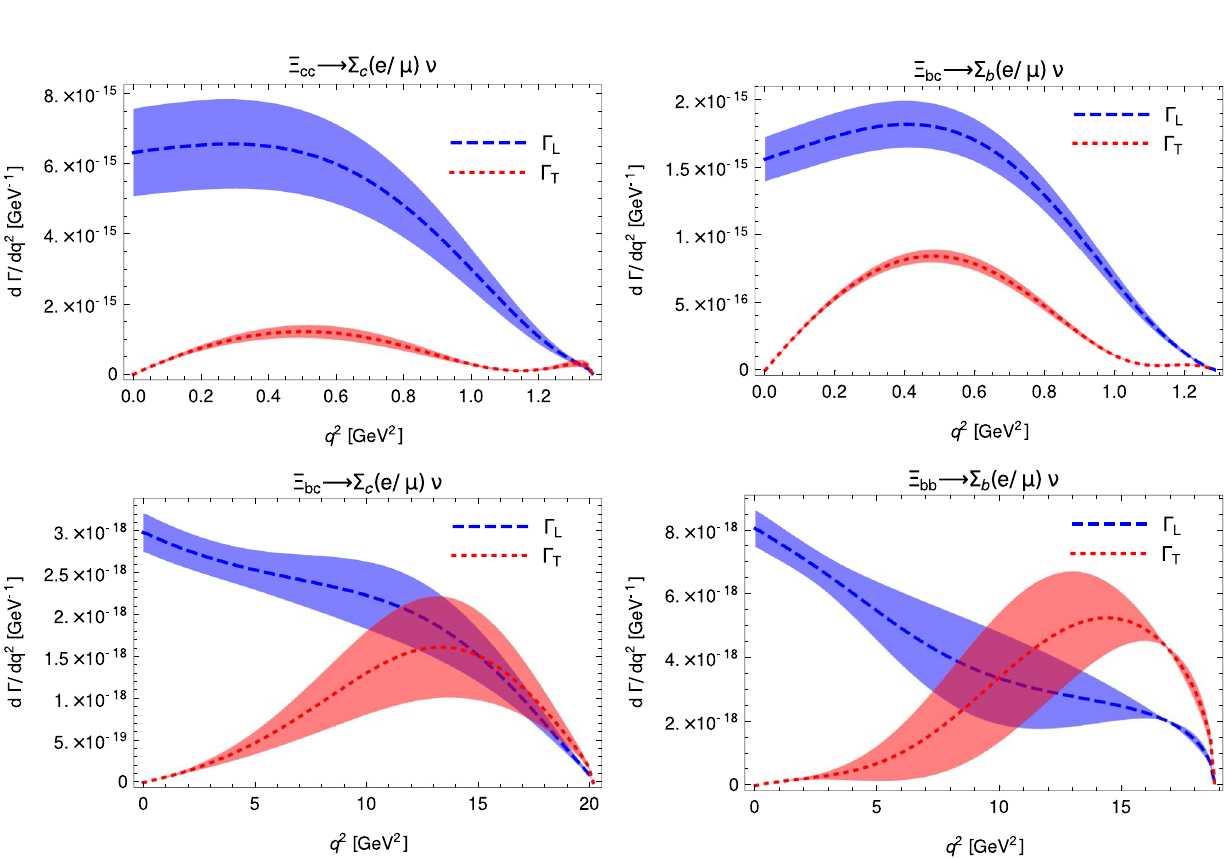
→ (cid:3) ν and the band width reflects the corresponding error. For the case of l Q (cid:2) q 1 q 2 l 2 (cid:2) → (cid:3) QQ (cid:2) q Q (cid:2) qq , the vertical scale needs to be enlarged by a factor